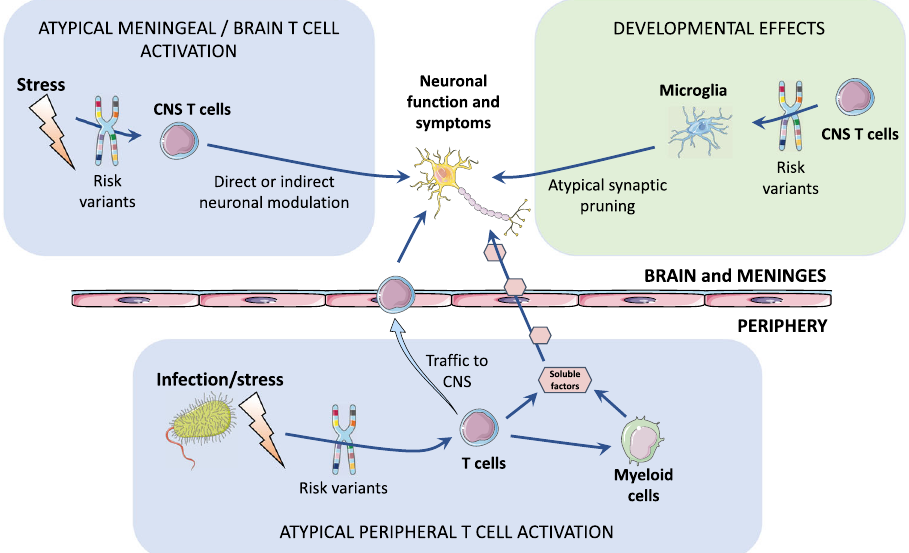
Fig. 5 | Schematic of potential pathogenic pathways by which genetic risk variantsenrichedatepigeneticallyactivesitesinTcellscouldleadtoneuronal changes and ultimately psychiatric disorders. Infection or other stressors may induceactivationofregulatoryelementsinTcellsthatareenrichedfortrans-orcis- diagnostic risk variants, potentially leading to atypical T cell phenotypes and downstreamactivation ofinnate immune (myeloid) cells in the periphery and CNS (light blue boxes). Atypical activation of T cells resident in the CNS, or traf fi cking into the meninges and brain from the periphery, could adversely affect